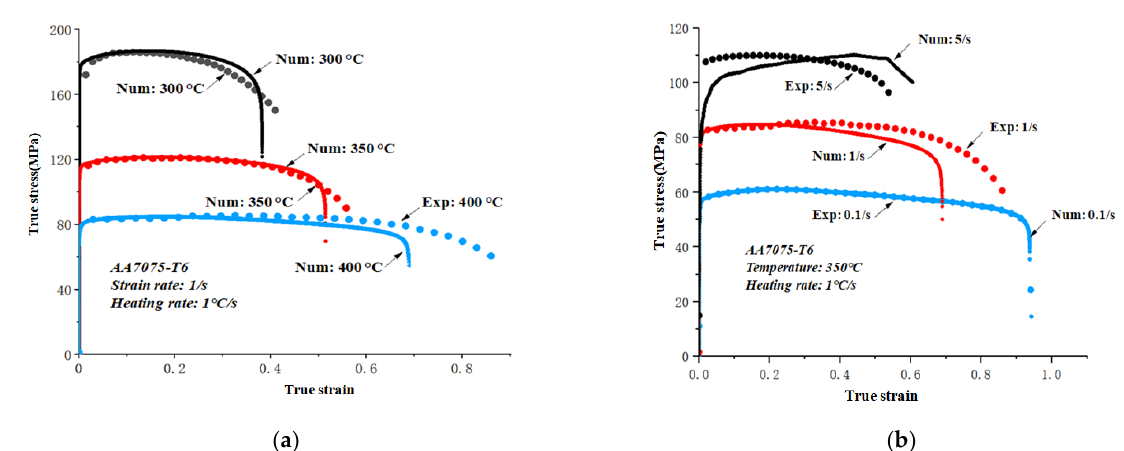
Figure 7. Comparisons of hot flow results under uniaxial stress state between experimentation and model computations results at various deformation conditions: ( a ) temperature effect, ( b ) strain rate effect. Solid symbols represent experimental results and solid lines represent numerical fittings.